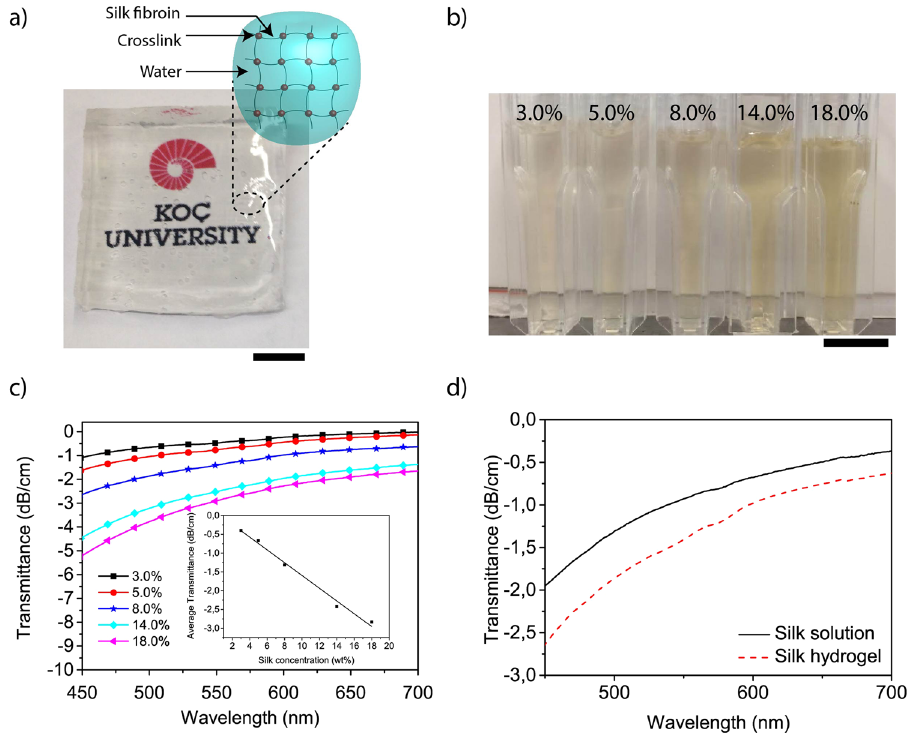
Figure 1. Optical properties of silk hydrogel. ( a ) Photograph showing the level of transparency of a silk hydrogel piece placed on top of the Koc University logo printed on a paper; inset: schematic of silk hydrogel structure showing water molecules that are trapped inside covalently crosslinked silk fibroin proteins. Scale bar, 0.5 cm. ( b ) Photograph of silk hydrogels with concentrations of 3.0, 5.0, 8.0, 14.0 and 18.0 wt%, respectively. Scale bar, 1 cm. ( c ) Transmittance of silk hydrogels in dB/cm units in visible spectrum at concentrations of 3.0, 5.0, 8.0, 14.0 and 18.0 wt%, respectively. Inset: Averaged transmittance of silk hydrogels in the visible spectrum. ( d ) Comparison of transmittance between the silk solution and hydrogel at the same concentration (8.0